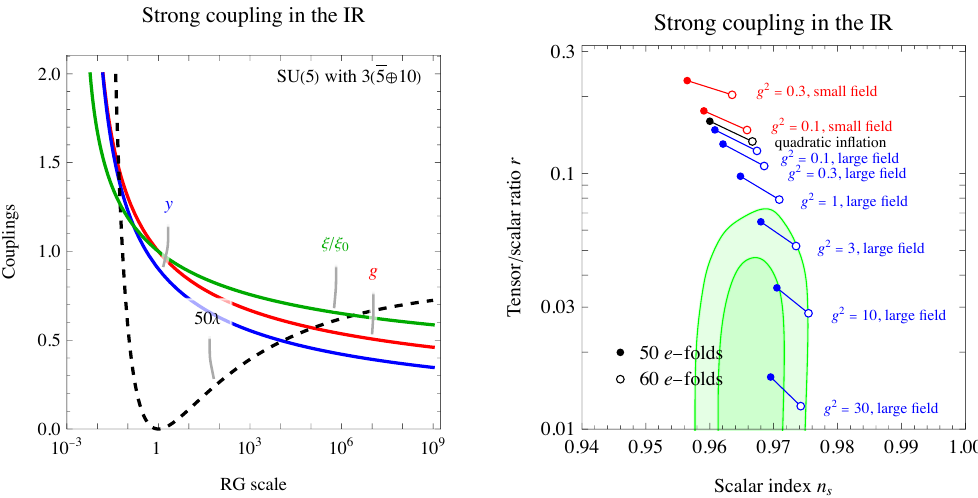
= 3 and gauge coupling f